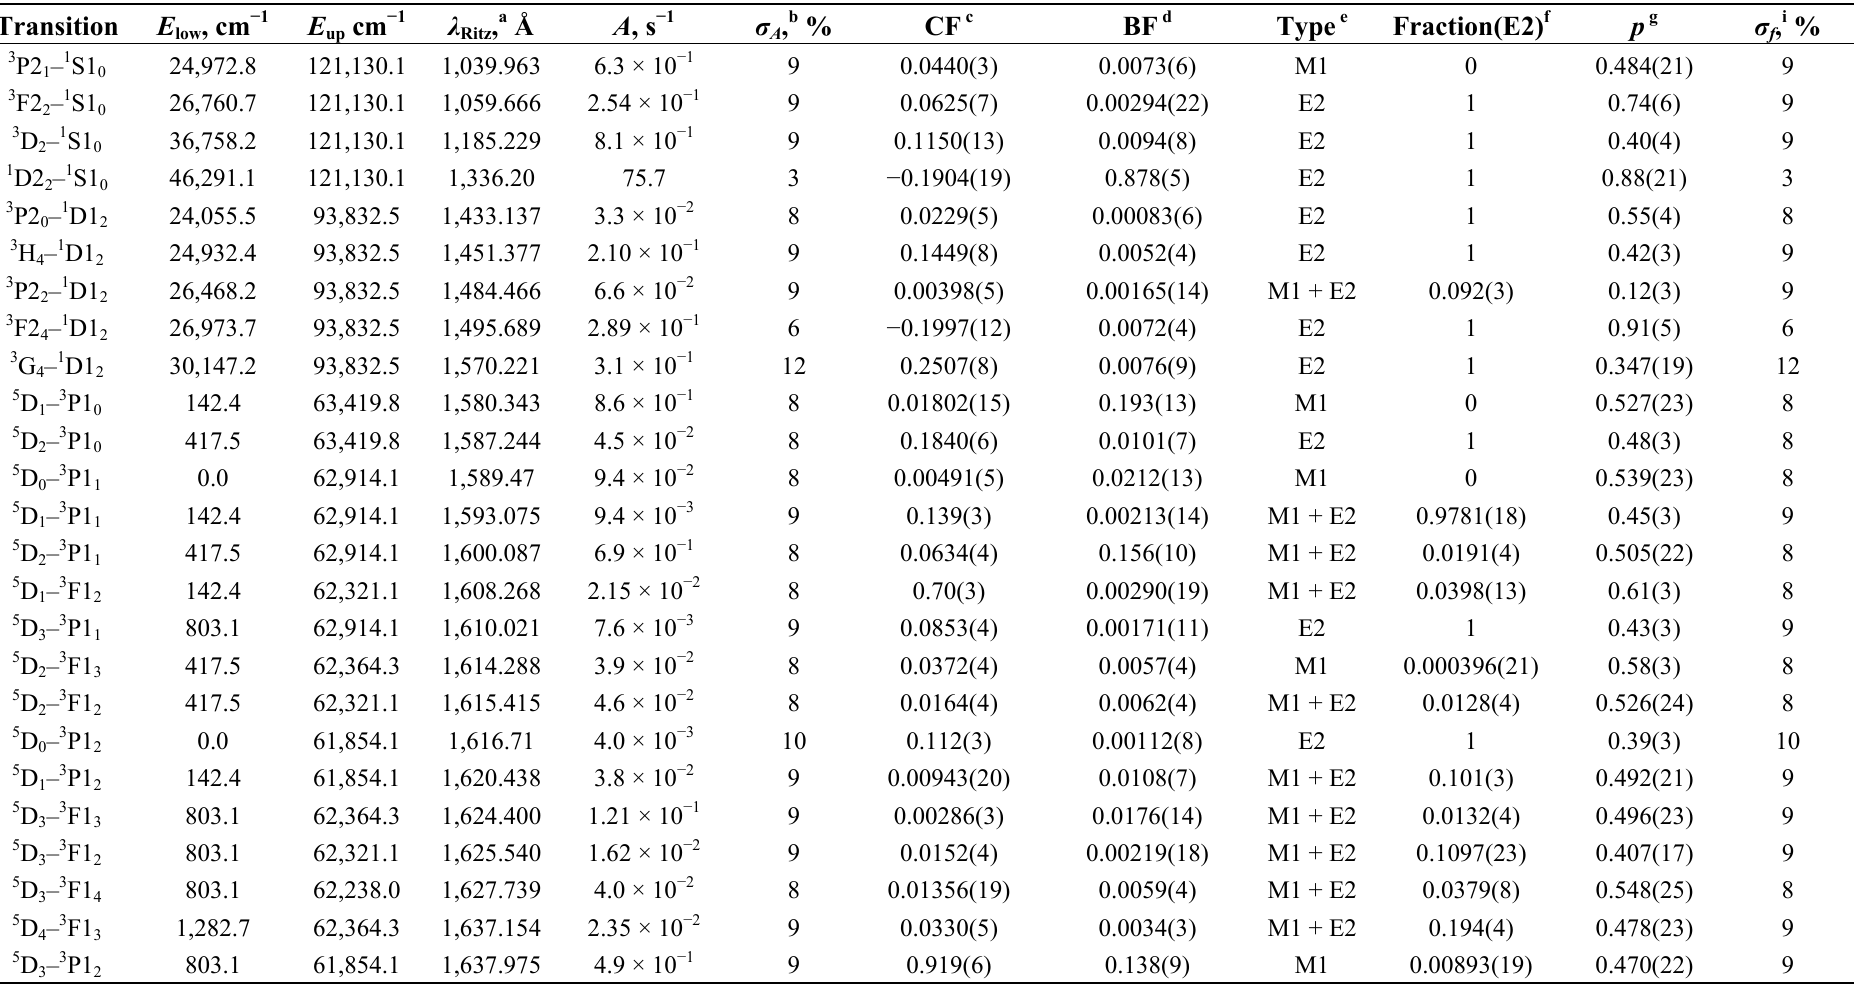
Table 3. Calculated transition probabilities of M1 and E2 transitions of Fe V with estimated uncertainties and Box–Cox transformation parameters optimized for each transition, based on overall statistics for five sets of Monte Carlo trials, four with 1,000 trials each and one with 10,000